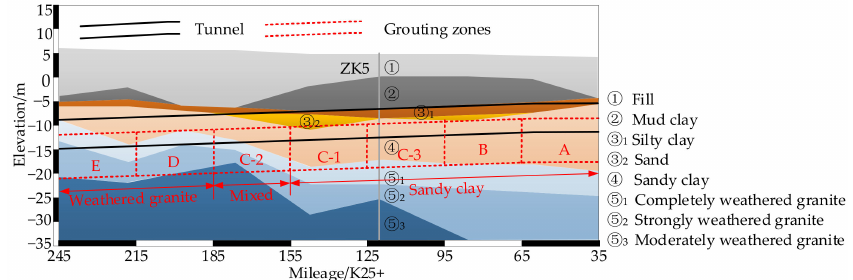
Figure 3. Geological